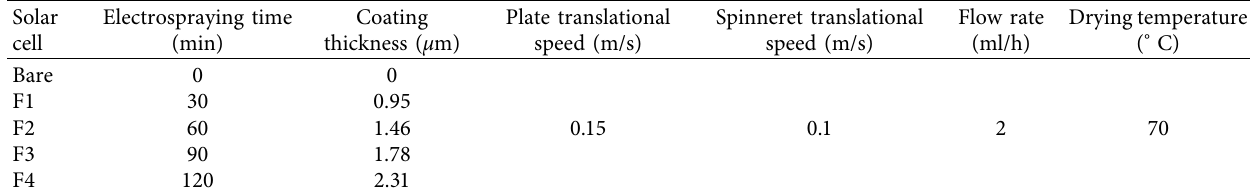
Table 1: Coating parameters of an electrospray deposition